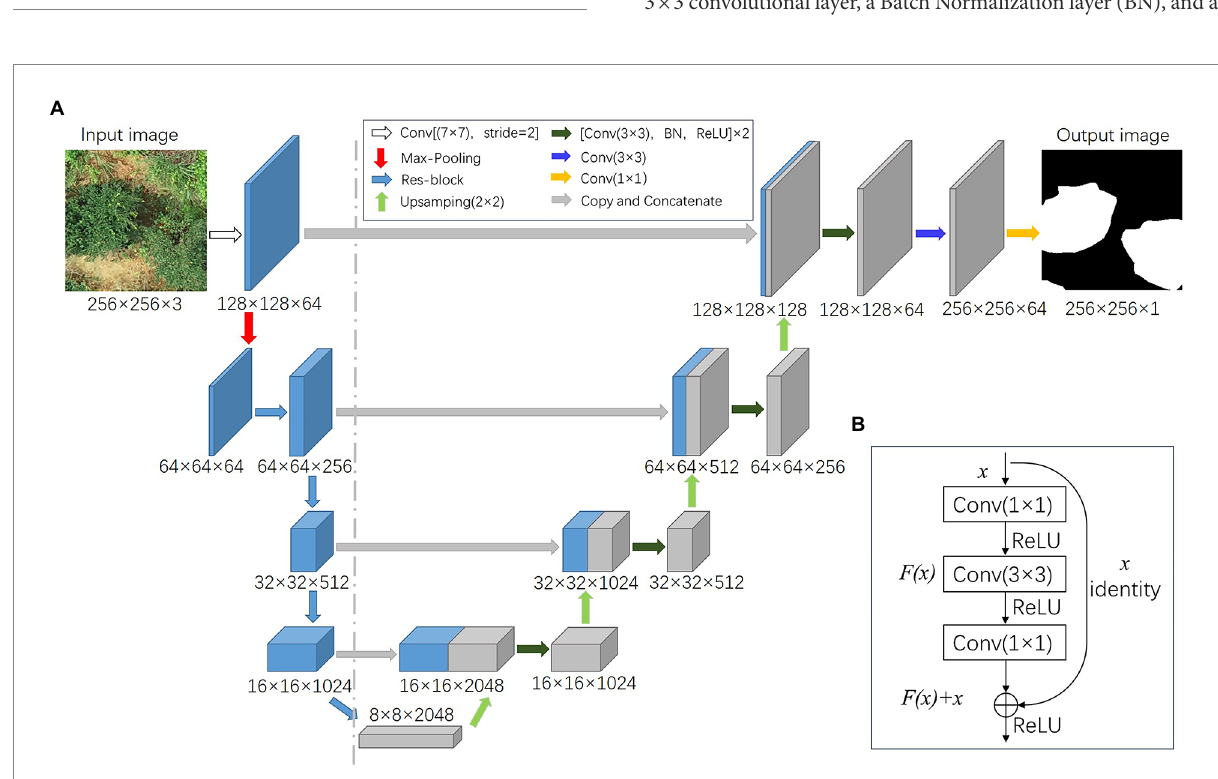
FIGURE 3 ResU-Net network structure: (A) ResU-Net network framework; (B) Res-block